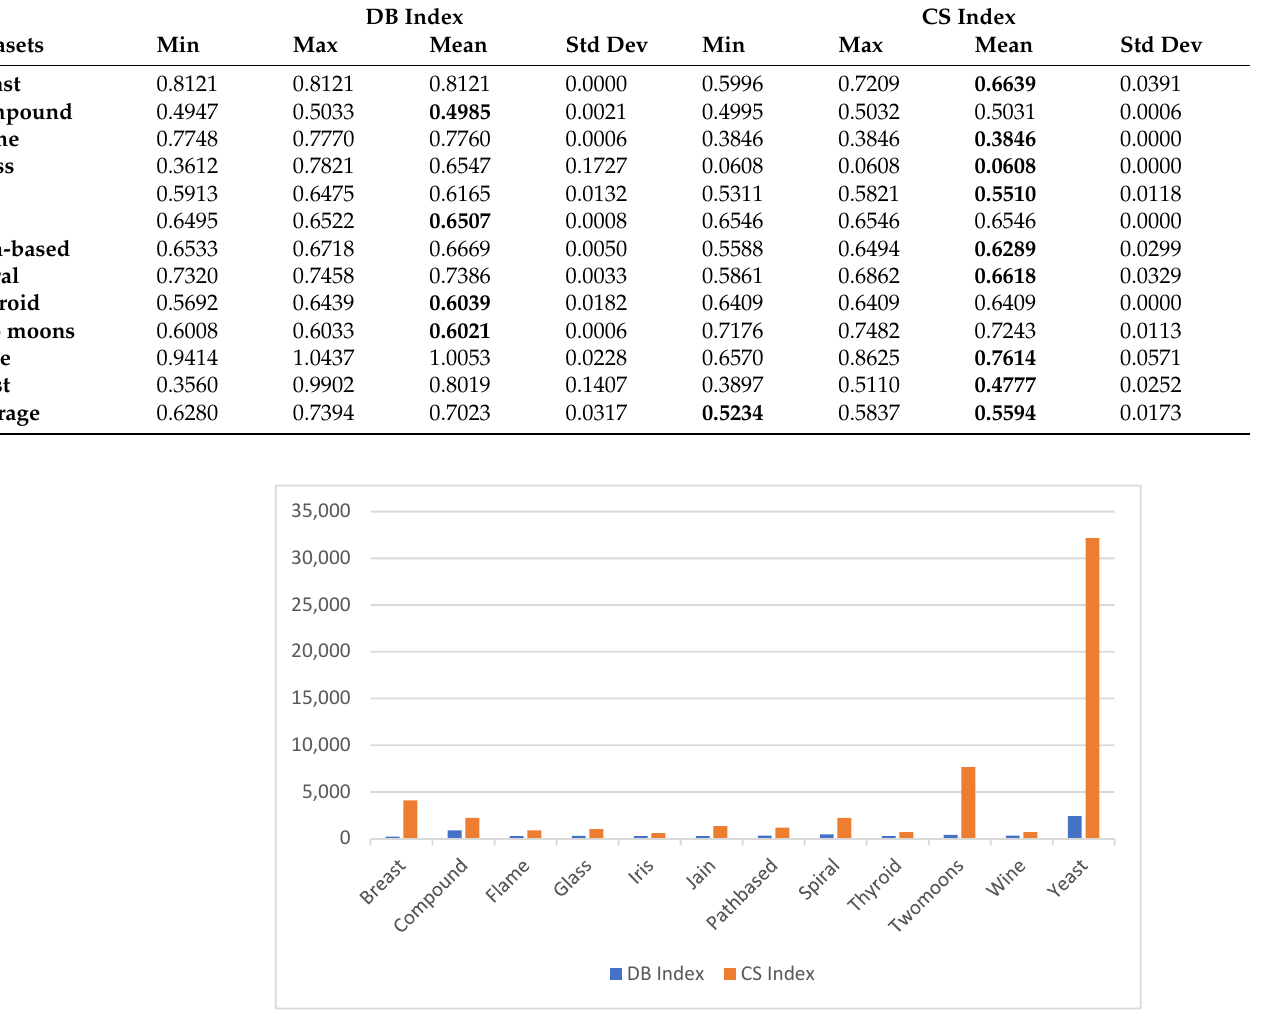
Figure 3. Computational time for the ISOSK-means. Table 5 summarizes the simulated results for each of the four competing algorithms for the automatic clustering of the 12 real-life datasets. The results present the mean and the standard deviation for each algorithm. The values were obtained for the two cluster validity indices, the DB index, and the CS index. Table 5. Computation results for the four competing algorithms on 12 real-life datasets. Statistical Measure